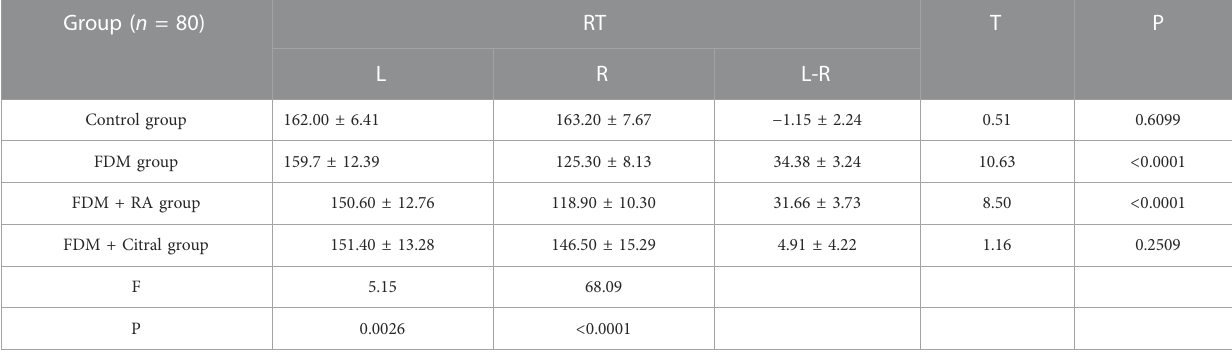
TABLE 5 RT results of left and right eyes of guinea pigs in each group measured by EDI-OCT ( μ m). Group ( n =